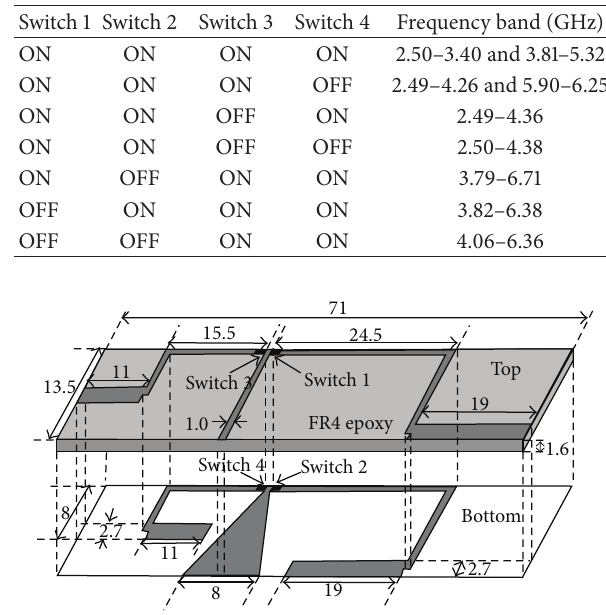
Figure 2: A proposed sensing and communicating antenna config- uration in [6] (dimension is